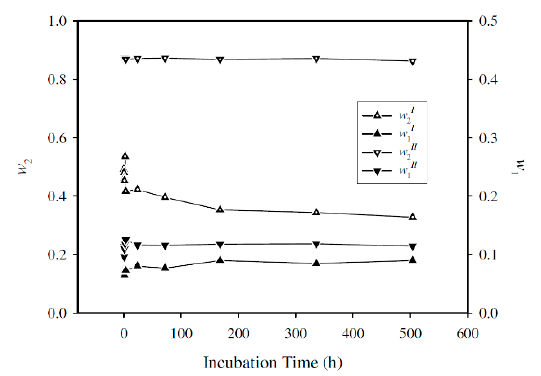
Figure 2. Concentration of phases formed as a function of incubation time for the system lactic acid (1) + water (2) + AE (3) at T = 308.15 K and P = 0.1 MPa (atmospheric pressure).